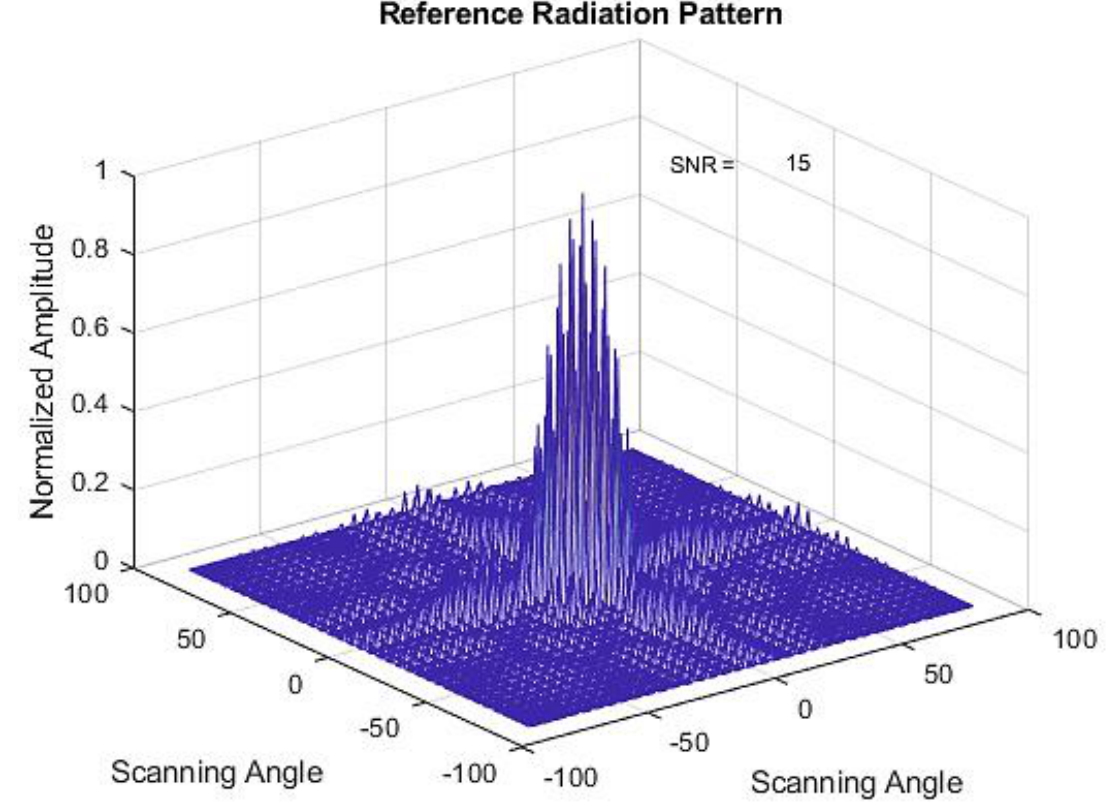
Figure 4. Radiation Pattern of an 8 × 8 planar array (reference radiation pattern) in a mesh grid representation.